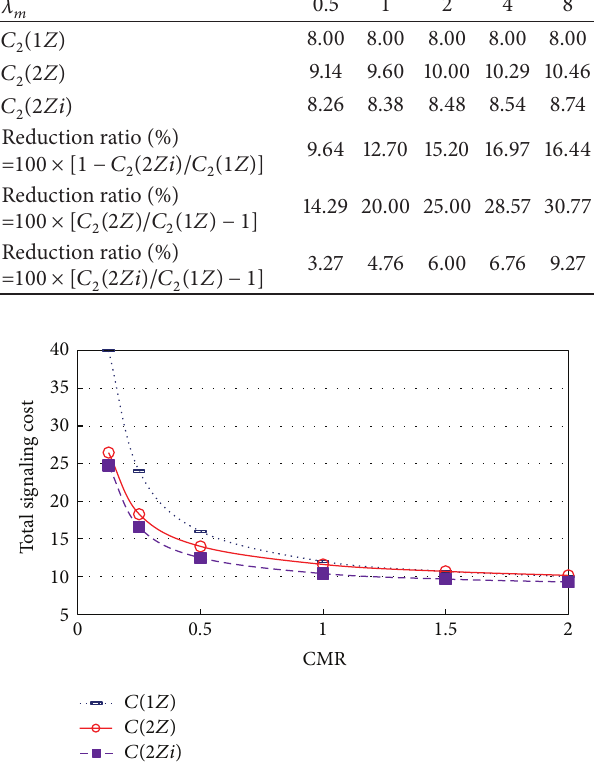
Figure 2: Signaling cost with respect to